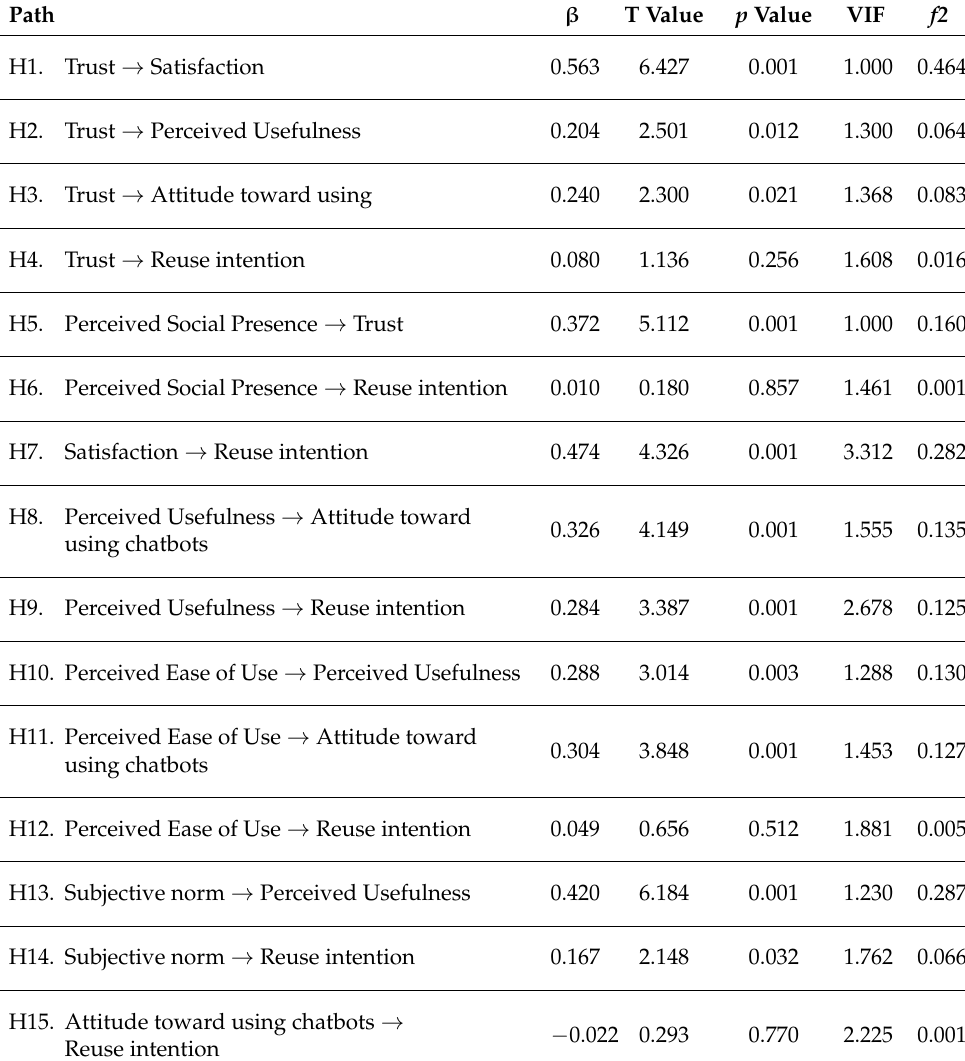
Table 4. Path Estimates for Proposed